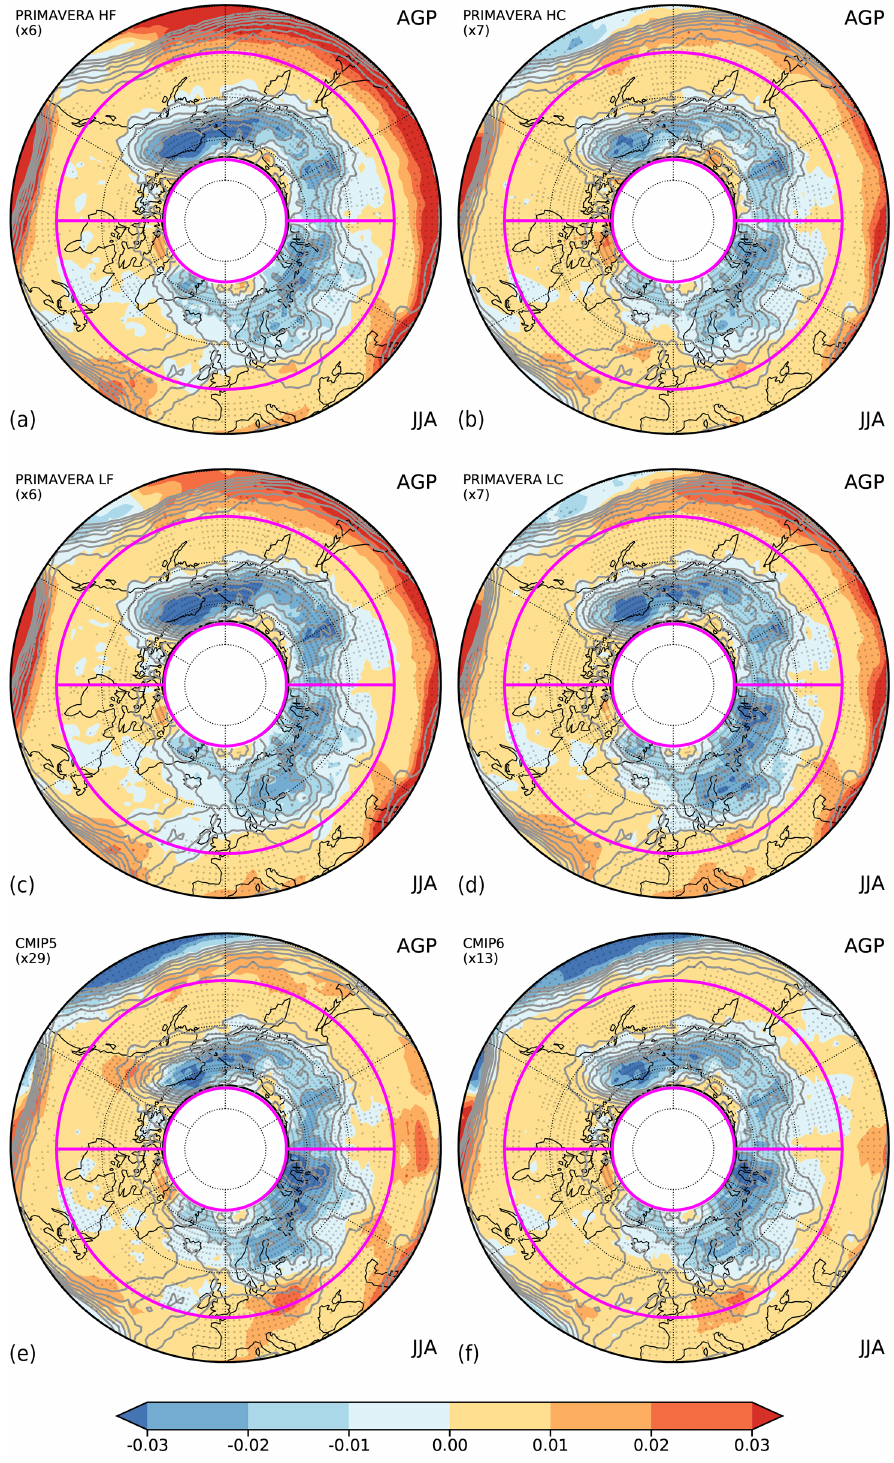
Figure 2. As in Fig. 1 but for boreal summer. Blocking frequency bias for the AGP index and (a) high-resolution forced, (b) high-resolution coupled, (c) low-resolution forced, (d) low-resolution coupled PRIMAVERA simulations, and (e) CMIP5 and (f) CMIP6 simulations. Stip- pling shows agreement on the sign of the bias by at least (a, c) 6 of 6, (b, d) 6 of 7, (e) 19 of 29, and (f) 10 of 13 simulations. Grey contour lines show the reanalysis blocking frequency at contour intervals of 0.01 and starting from 0.01. ATL and PAC evaluation domains are shown by magenta